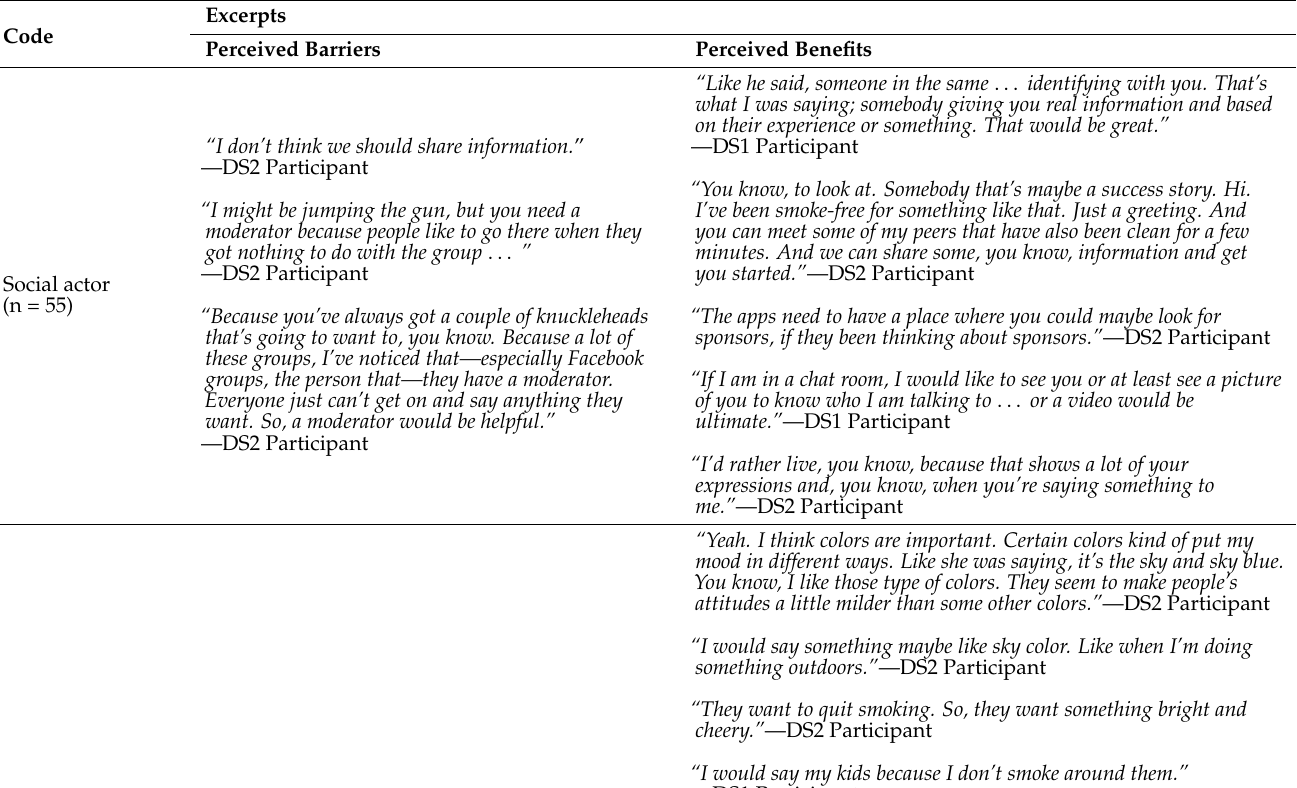
Table 3. Results from Design